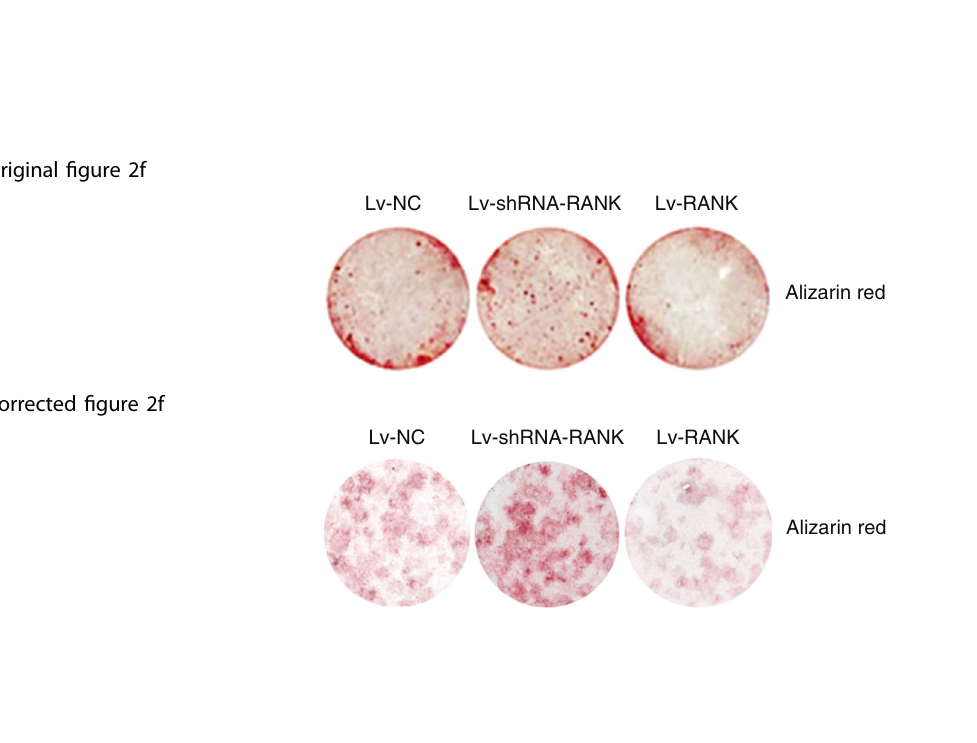
infected with Lv-RANK and (3 and 4) was infected with Lv-shRNA-RANK. Right: Detection of intracellular RANK protein